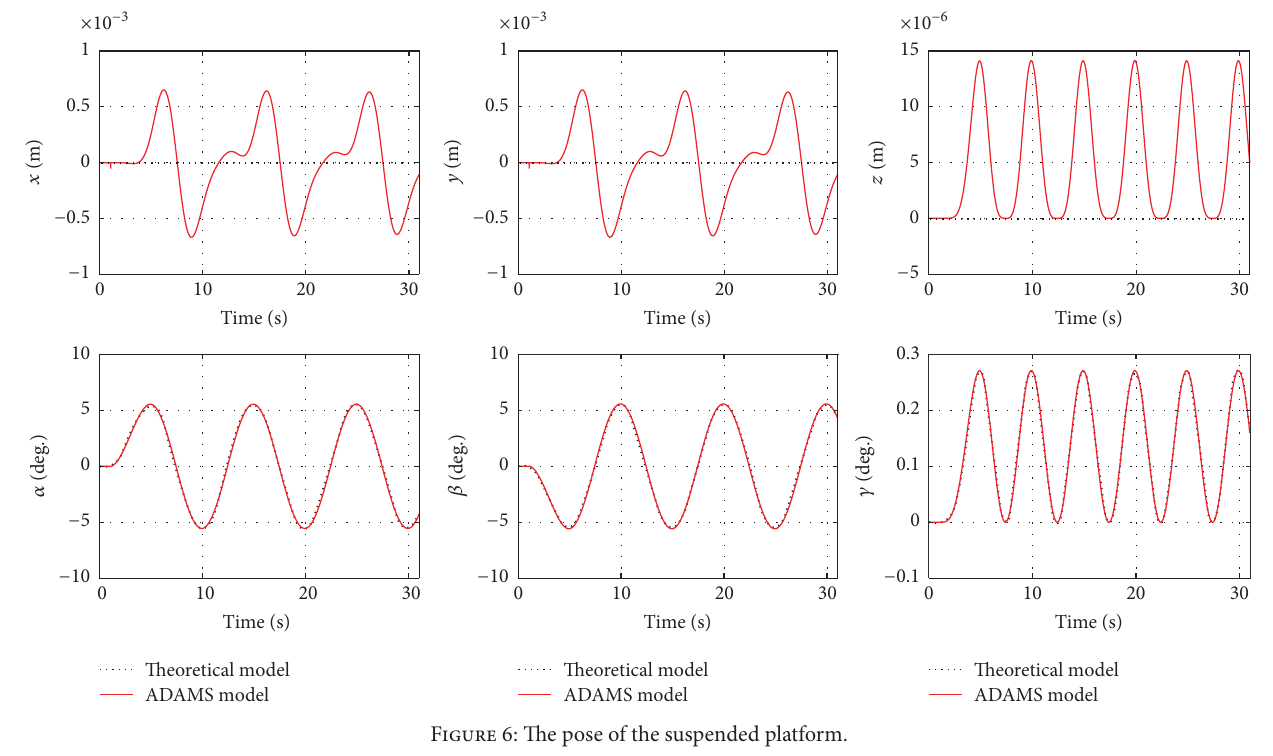
Figure 6: The pose of the suspended platform.